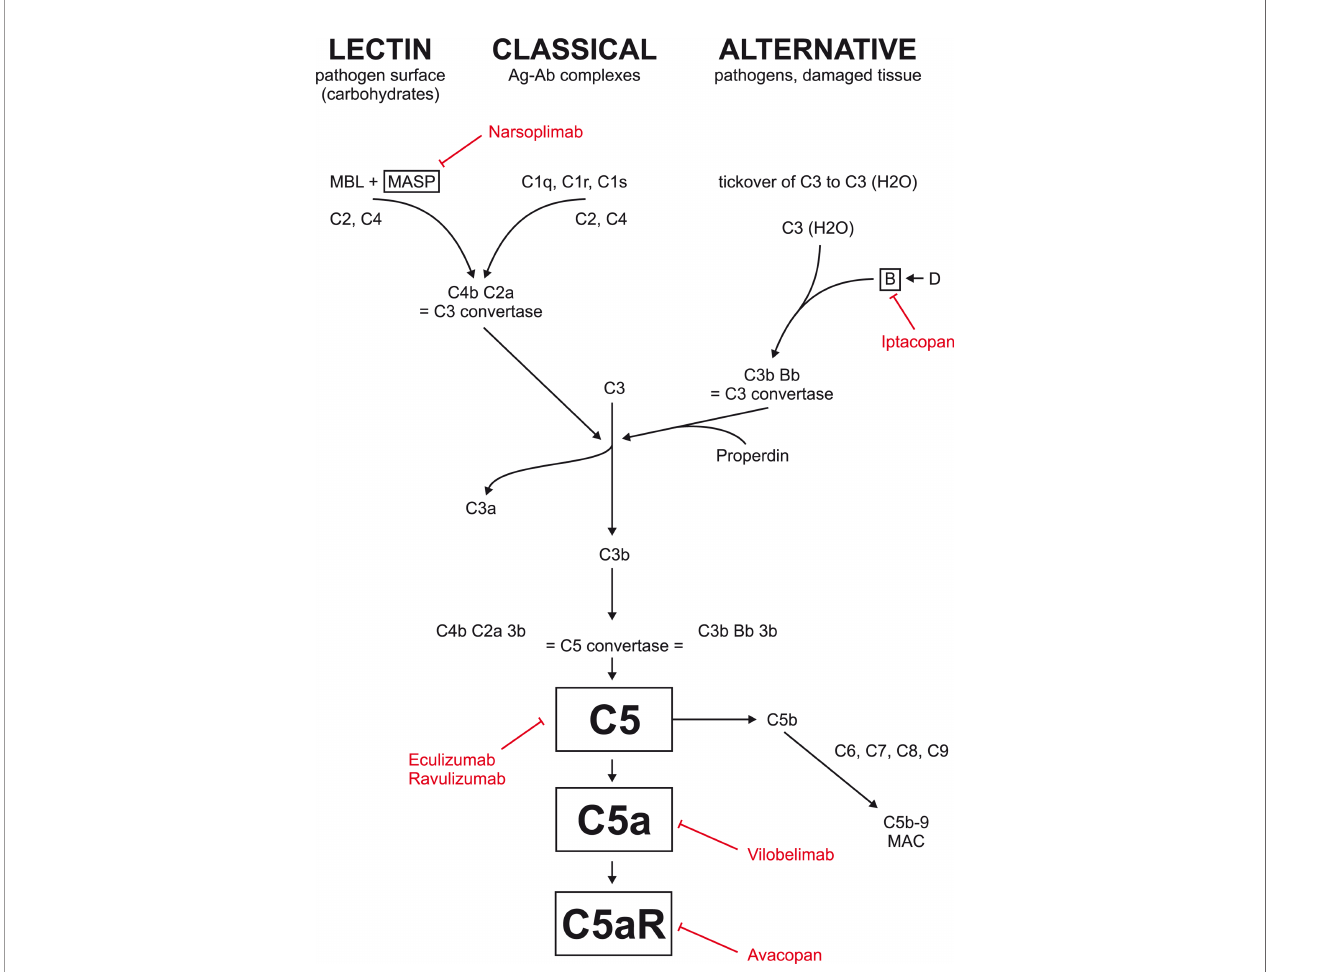
FIGURE 1 | Complement inhibition currently tested in glomerular disease. Eculizumab and ravulizumab are antibodies against factor C5 used primarily in atypical hemolytic uremic syndrome. Avacopan is an oral inhibitor of C5a receptor. Vilobelimab is an antibody against factor C5a. Narsoplimab is antibody against MASP and is currently tested in IgA nephropathy. Iptacopan is an oral factor B inhibitor currently tested in IgA nephropathy, membranous nephropathy, and C3